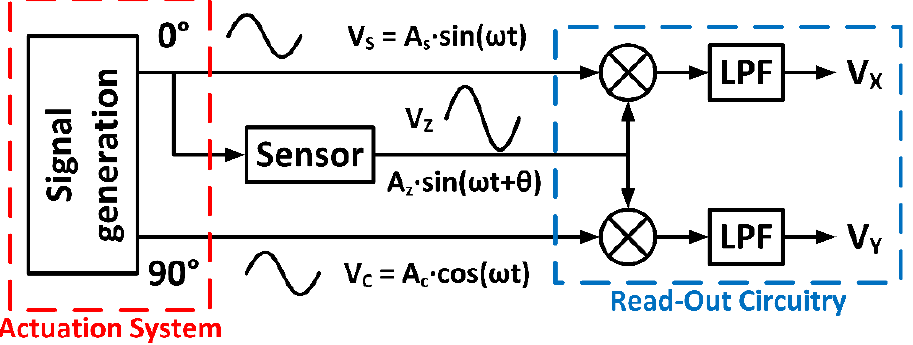
Figure 1. Conceptual scheme of the phase sensitive detection (PSD) technique.